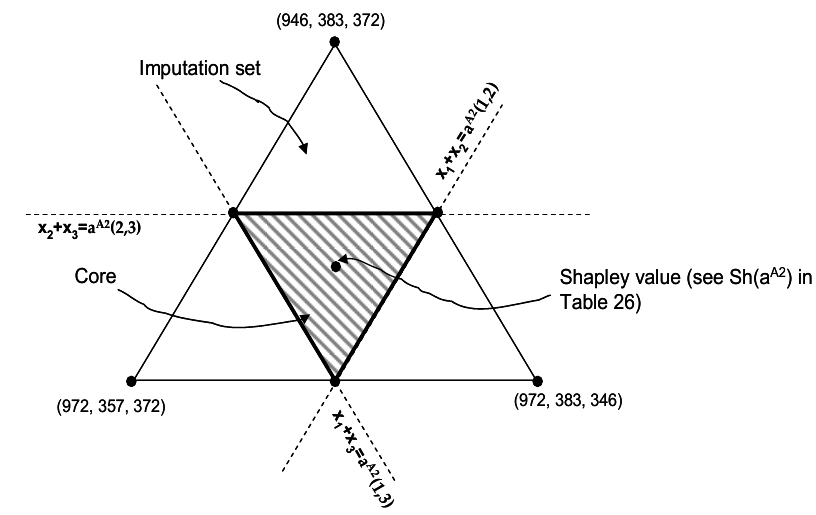
Figure 4. Present values of cost and revenues games under Alternative A2. Investment cost: Present values of coalitions in the investment cost game i A2 . Running cost: Present values of coalitions in the running cost game i A2 . Labor cost: Present values of coalitions in the labor cost game a lp . Revenue: Present values of coalitions in the revenue game V A2 . NPV (revenues minus costs): Total net present value obtained as the difference between revenues and costs.